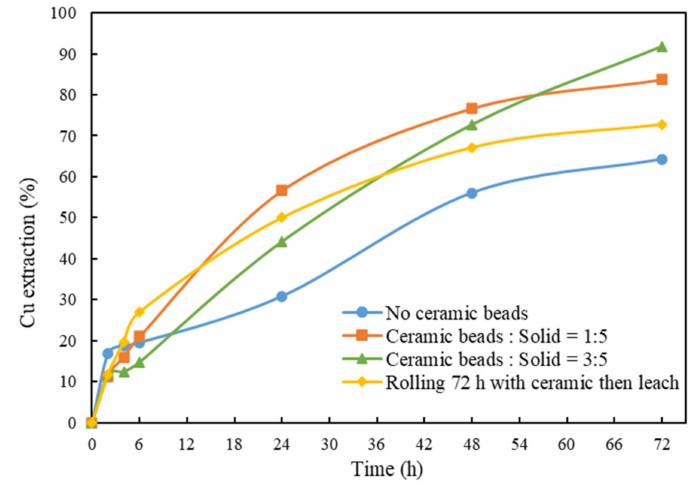
Figure 3. Cu extraction after 72 h of leaching using different amounts of ceramic beads. Other conditions: solid/liquid ratio = 1%, pH = 10.5, room temperature and Gly:Cu = 4:1.